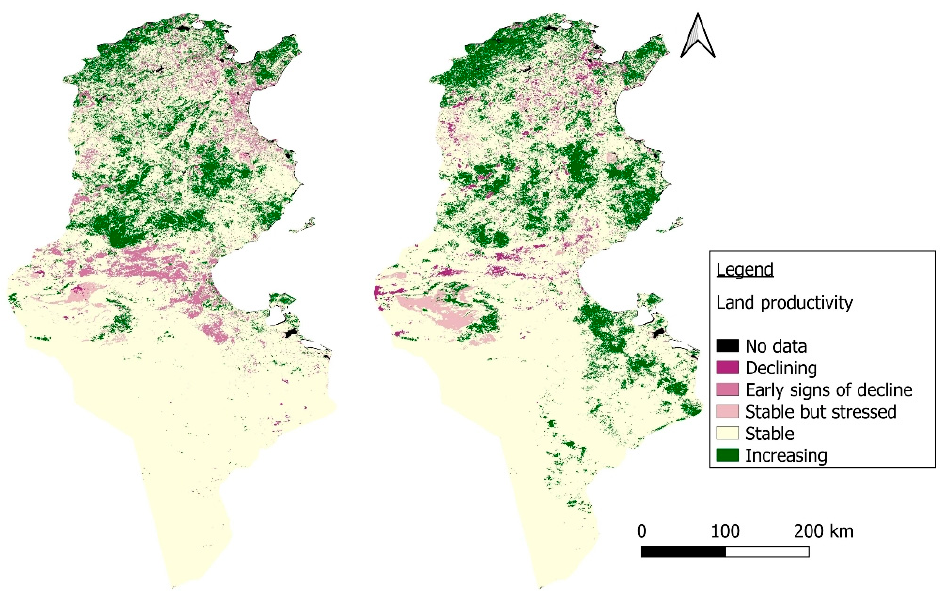
Figure 5. Spatial distribution of land productivity in Tunisia during the baseline period ( left ) and the reporting period ( right ).